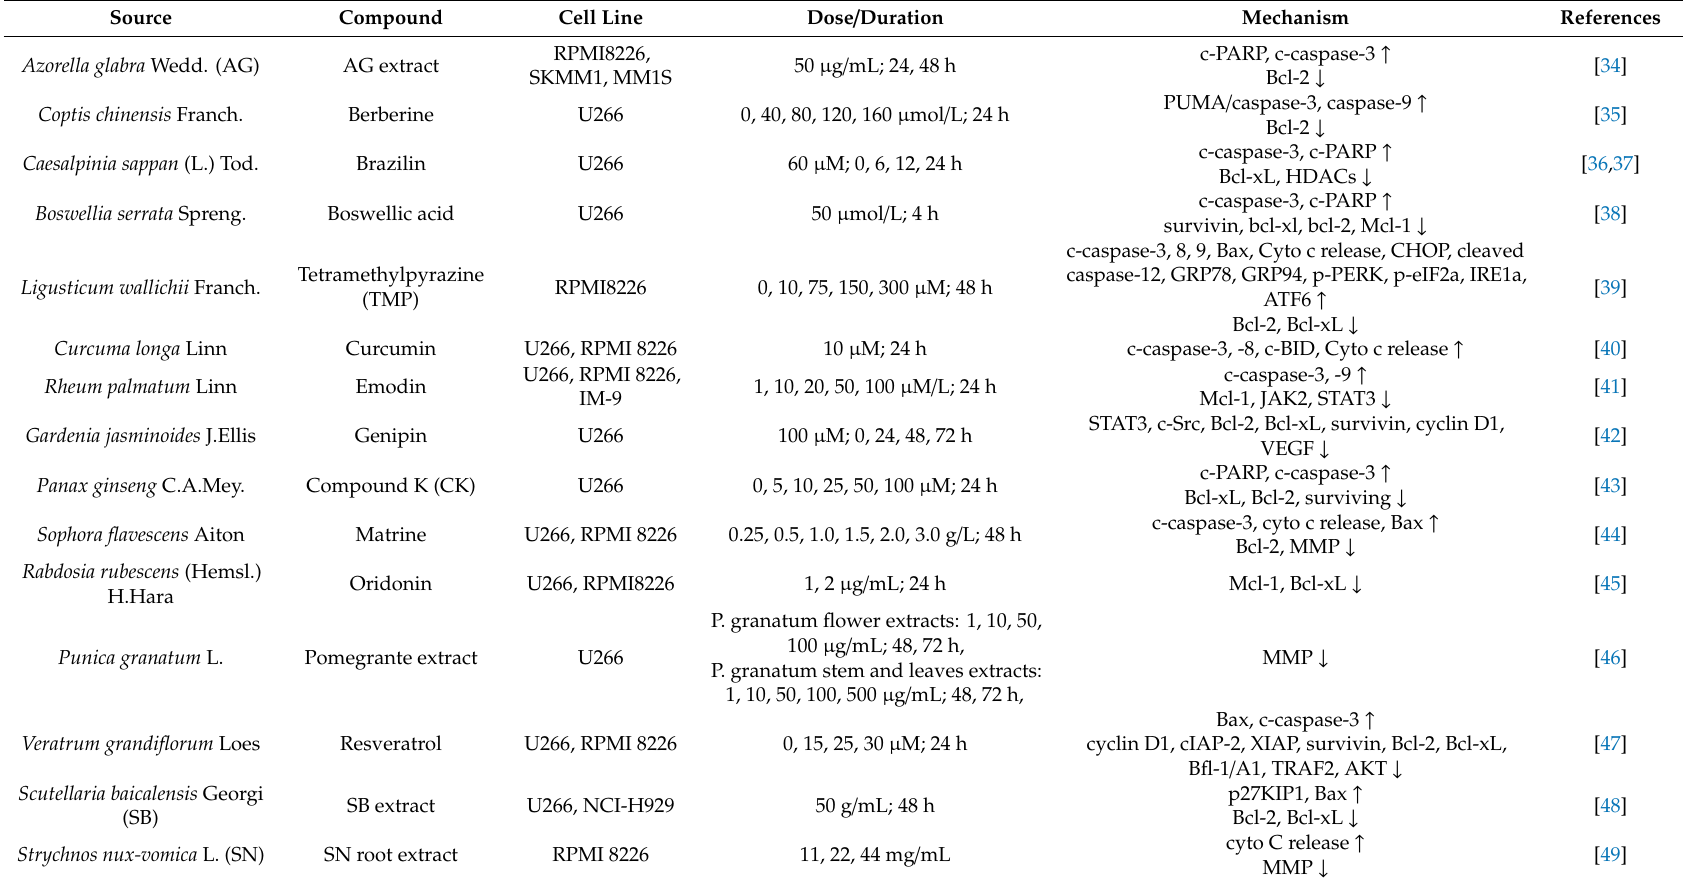
Table 1. Intrinsic pathway apoptosis inducing natural